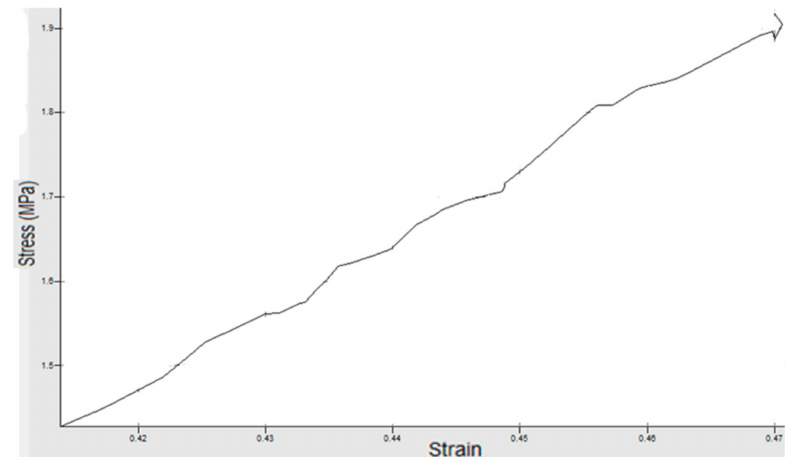
Figure 5. Piece 1 with speed v = 9mm/s and force F = 600 N.